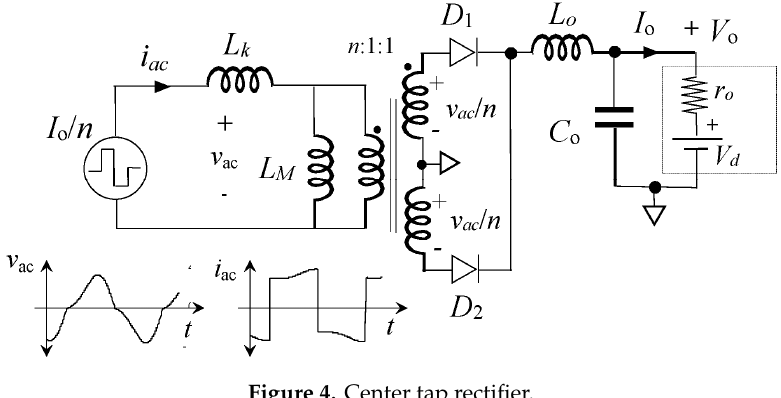
Figure 4. Center tap rectifier.